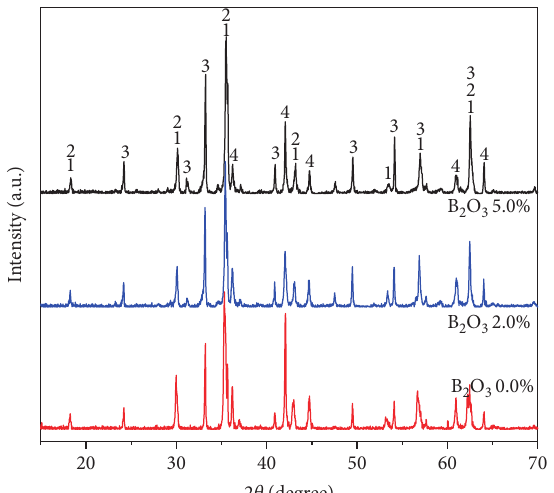
Figure 7: XRD patterns of H-VTM-sintered samples with different B